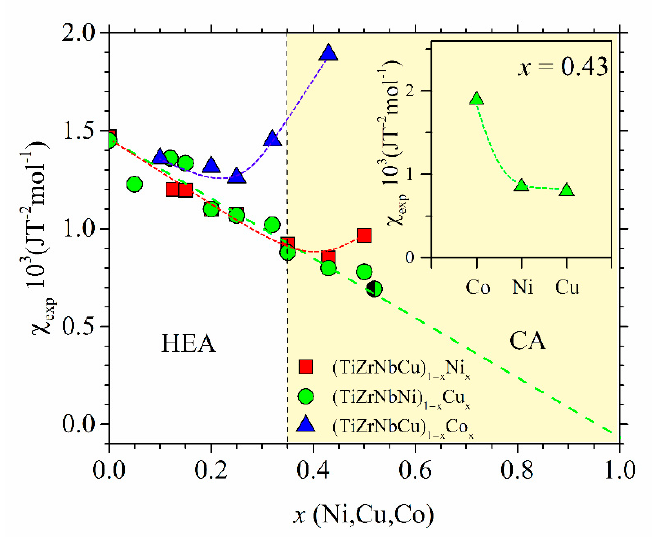
Figure 17. Room temperature magnetic susceptibility, χ exp , of (TiZrNbNi) 1 − x Cu x , (TiZrNbCu) 1 − x Ni x and (TiZrNbNi) 1 − x Co x MGs vs. x . The inset: χ exp of MGs with x = 0.43 Co, Ni and Cu.